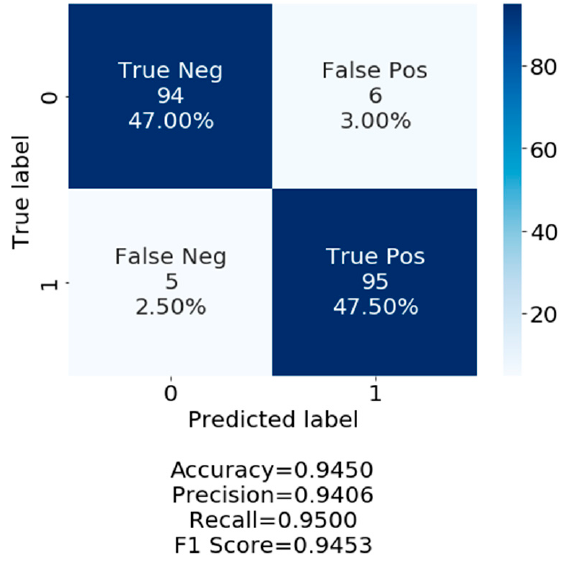
Figure 8. Confusion matrix for the test samples.